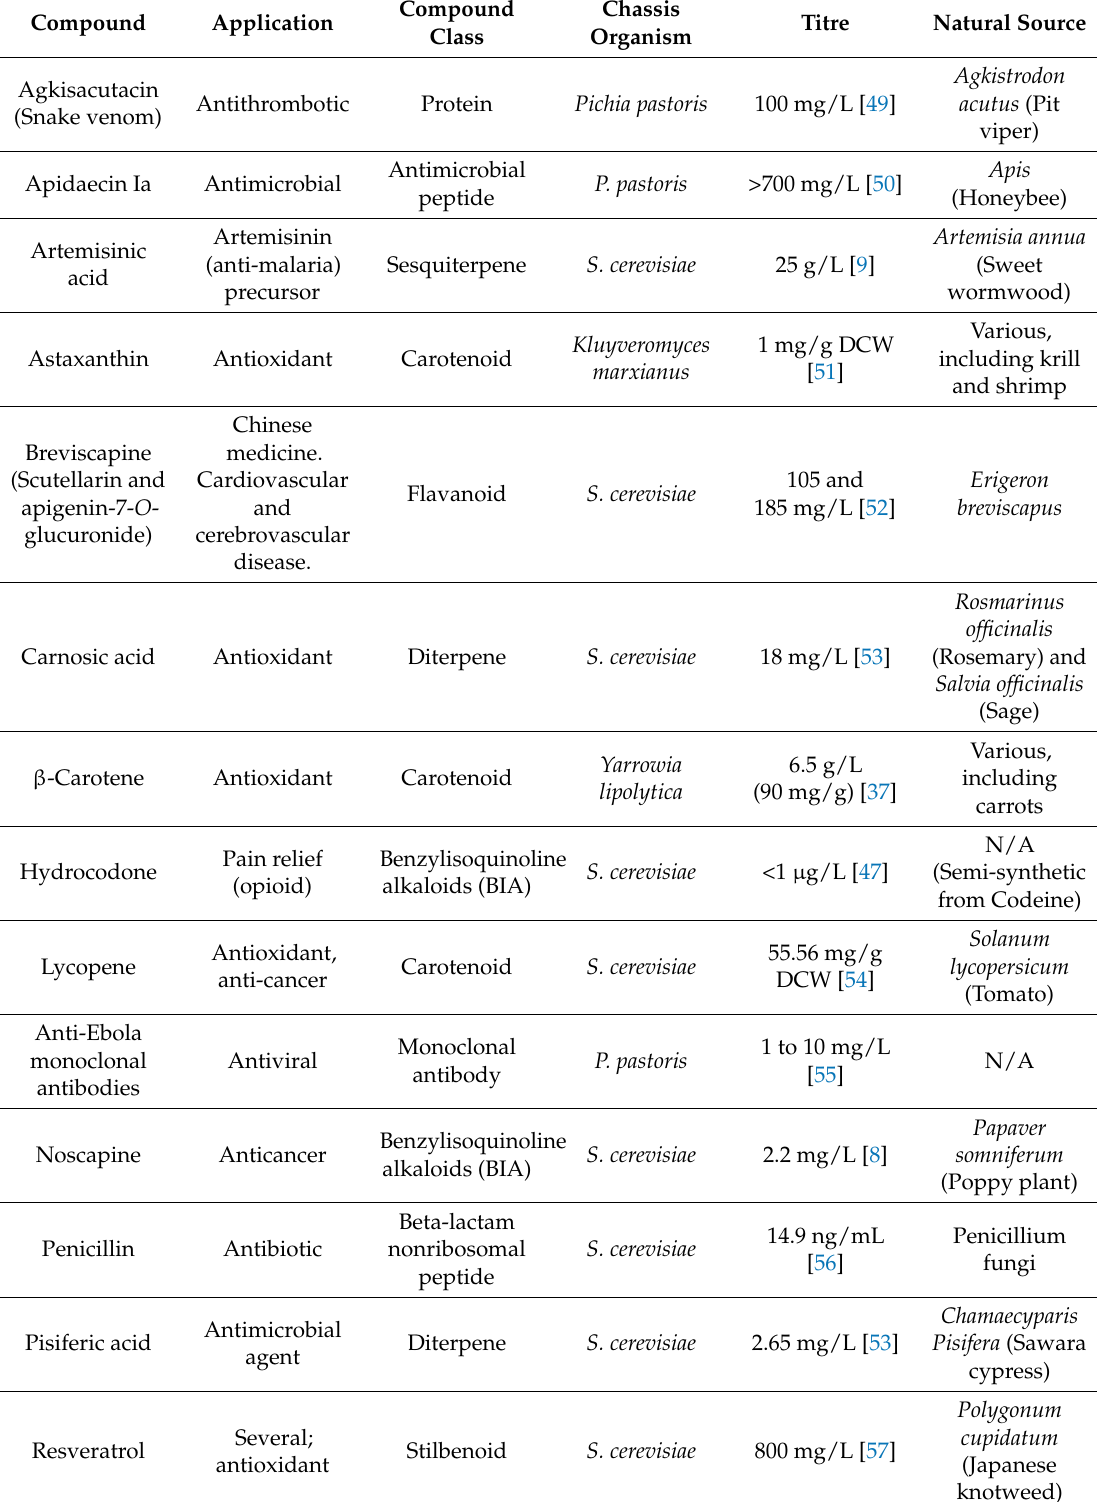
Table 1. Examples of biopharmaceutical compounds produced by applying yeast synthetic